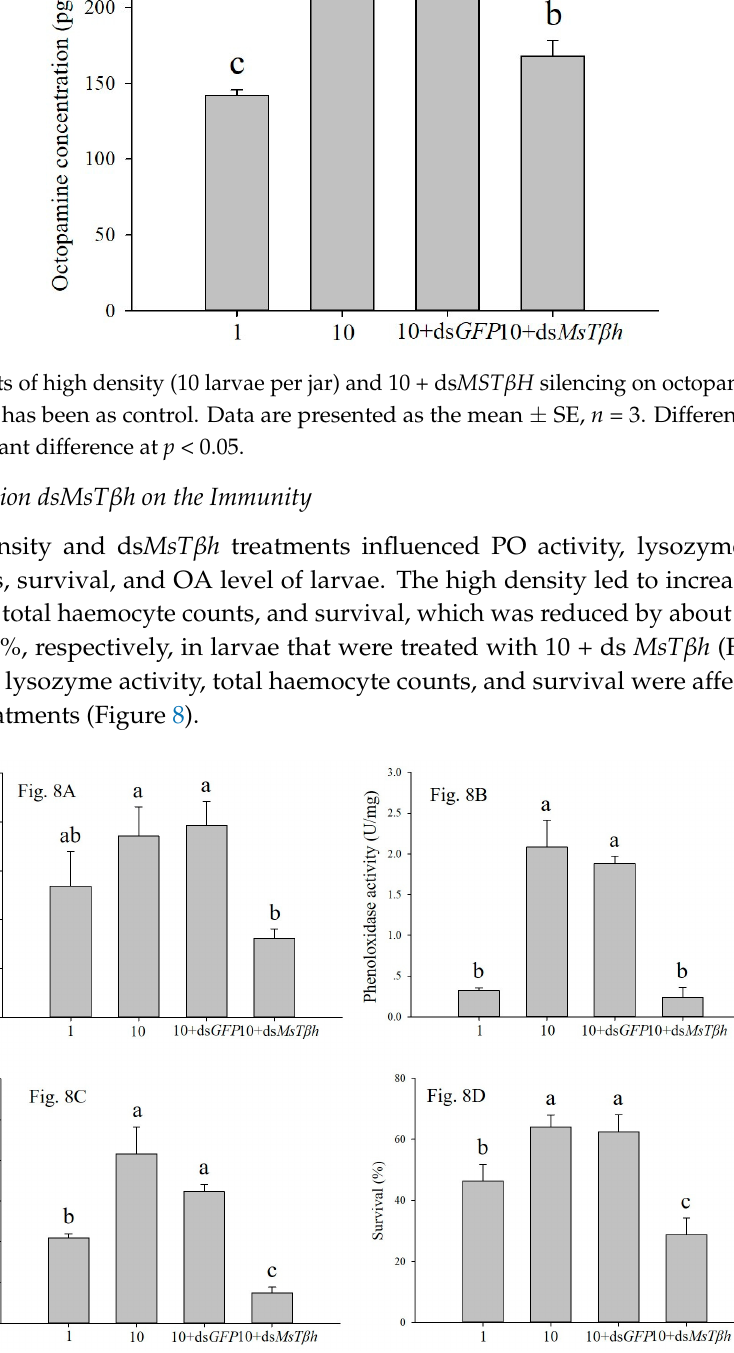
Figure 8. Effects of high density (10 larvae per jar) and 10 + ds MsT β h silencing on larval immune parameters and survival. ds GFP has been as control. ( A ) Total hemocyte counts; ( B ) Phenoloxidase activity; ( C ) Lysozyme activity; and, ( D ) Survival. Data are presented as the mean ± SE, n = 3. Different characters denote significant difference at p <